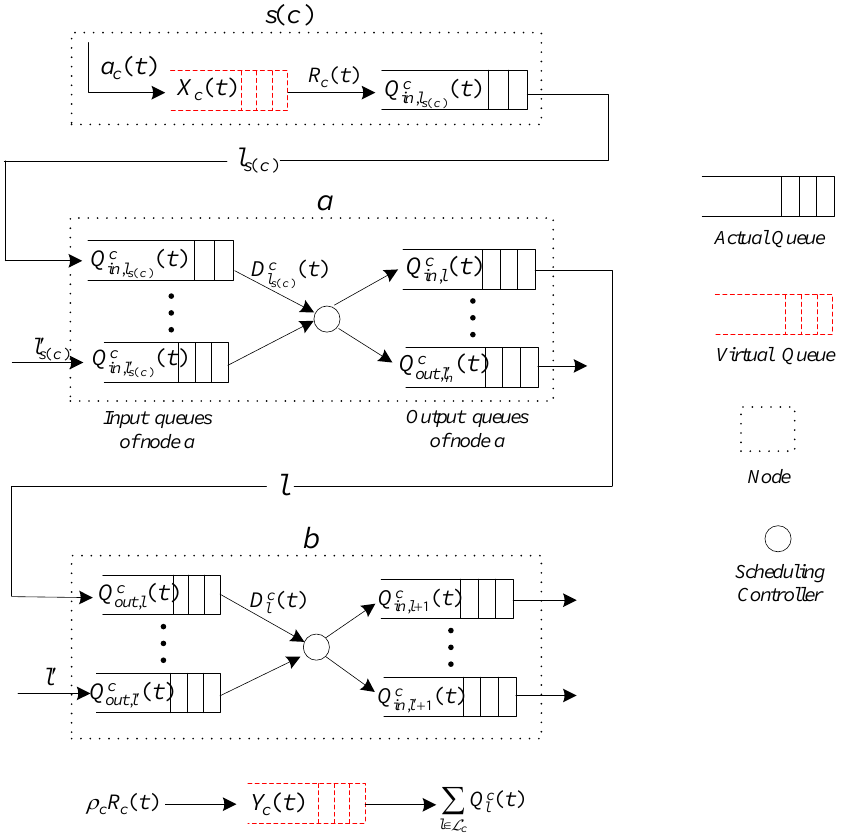
Figure 2. Actual and virtual queue model.